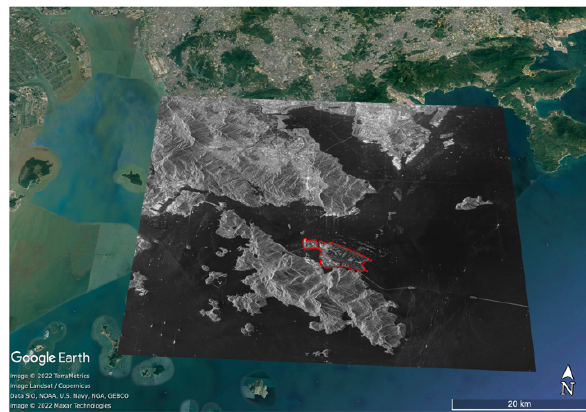
Figure 2 . Areas of coverage of SAR images used in the study. The location of HKIA is in the red area.